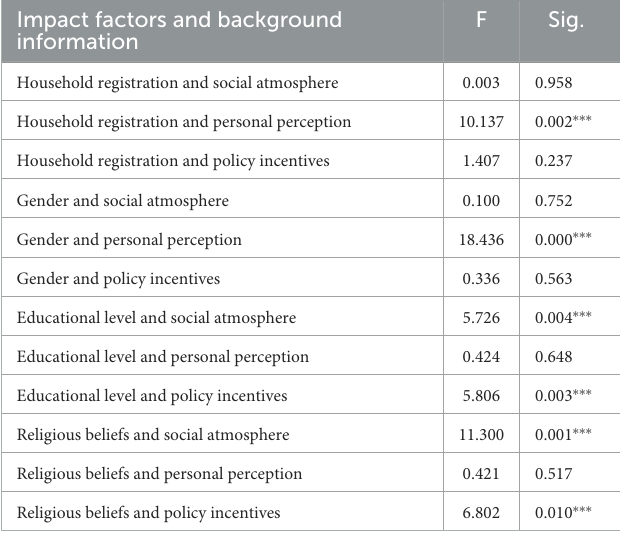
TABLE 13 ANOVA (willingness to be an organ donor).